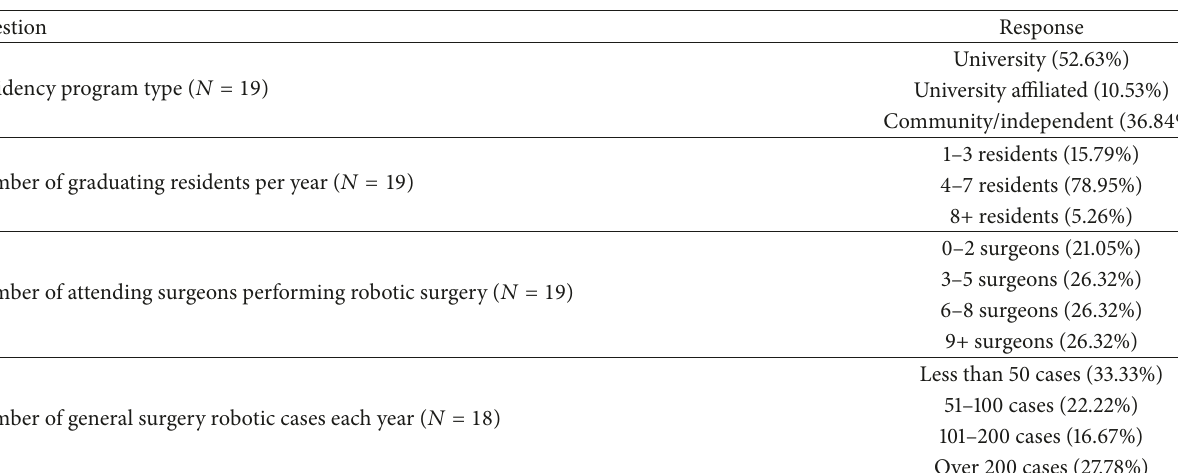
Table 1: Institution demographics.